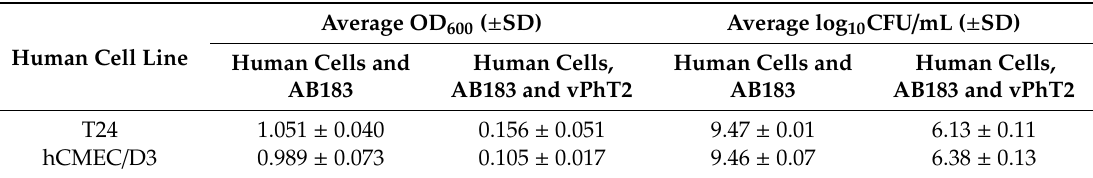
Table 8. Raw data for Acinetobacter baumannii turbidity (OD 600 ) and titre (log 10 CFU / mL) from samples grown in the presence of human cell lines.